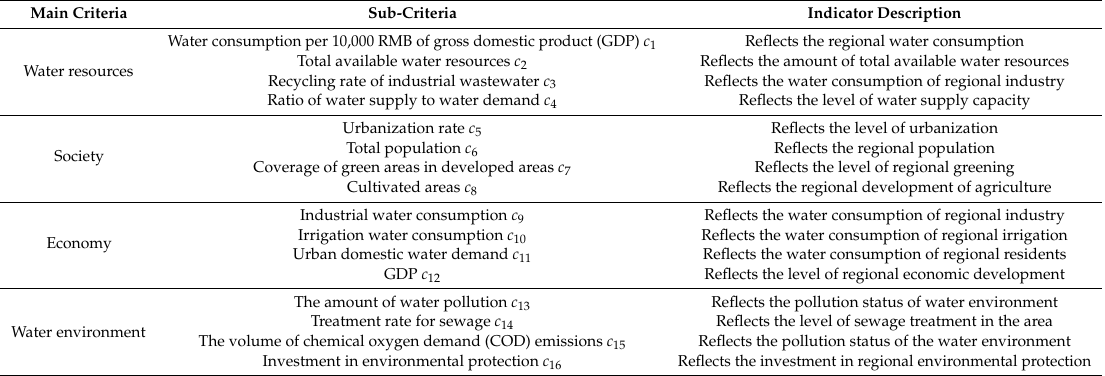
Table 1. The evaluation indexes of